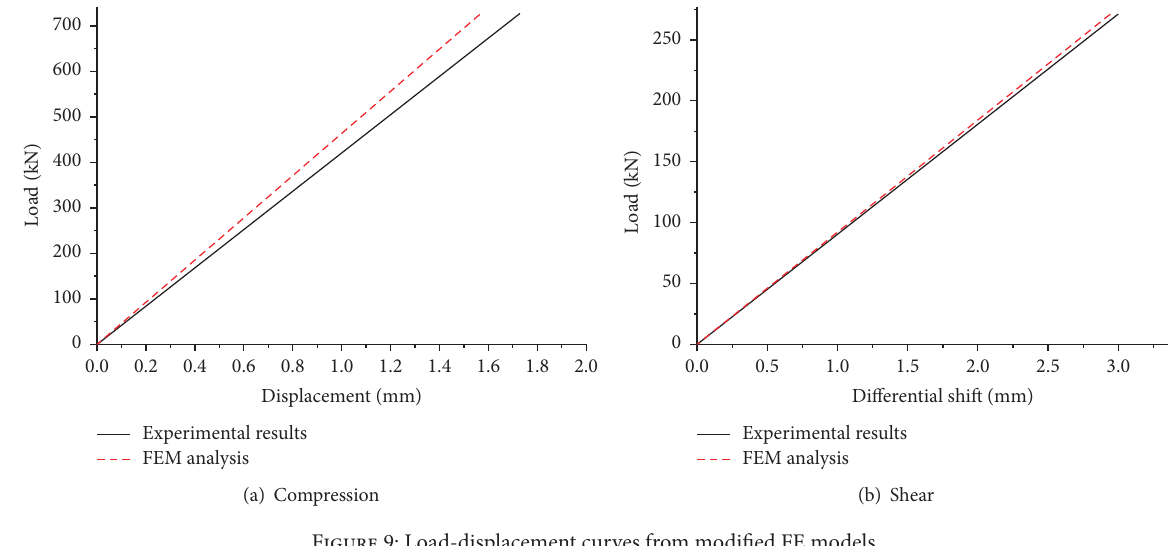
Figure 9: Load-displacement curves from modified FE models.